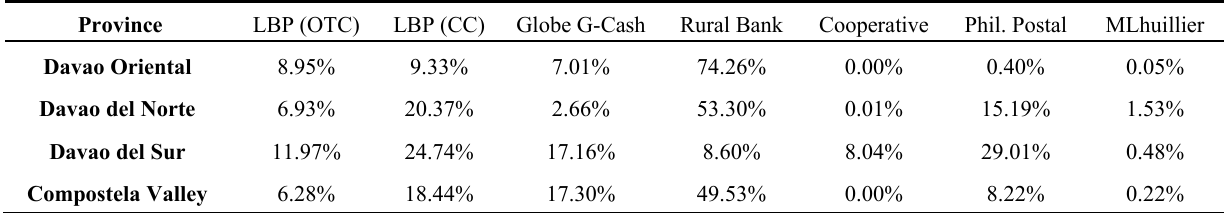
Table 5 . Percentage of transaction costs per payment scheme, per province (2008–2013).